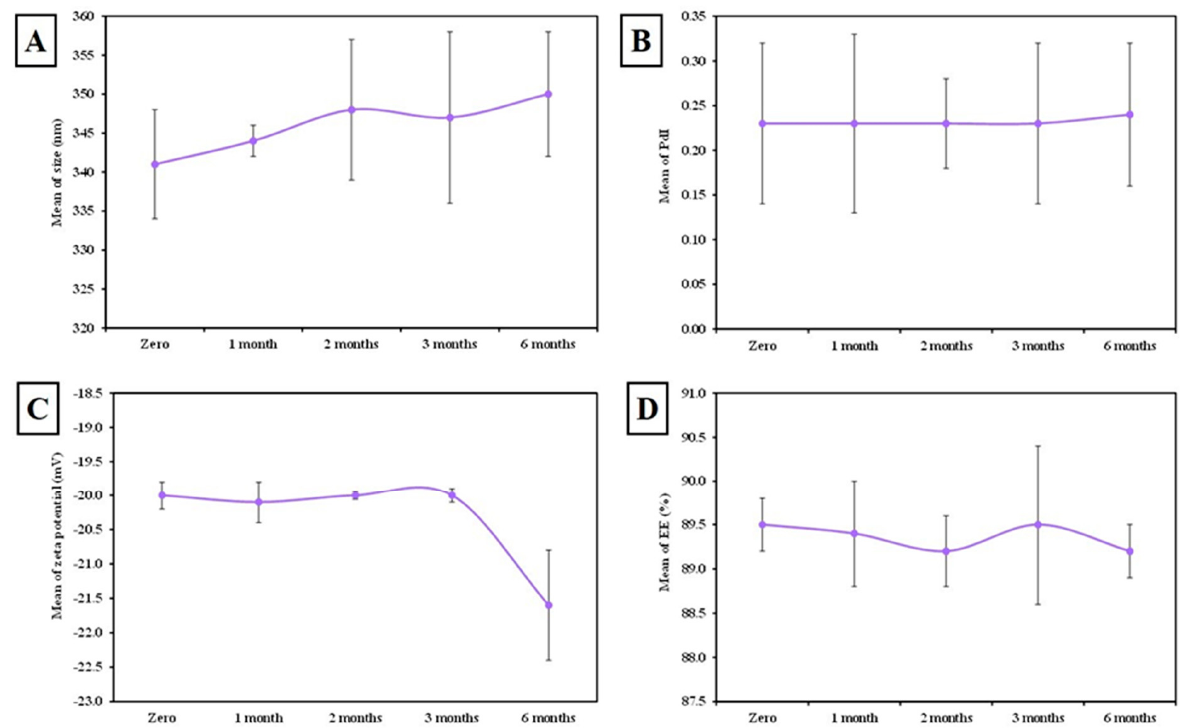
Figure 5. The storage stability of MLT-SLNs upon storage for six months at 4° C using particle size analysis ( A ), PDI ( B ), zeta potential ( C ), and EE ( D ).